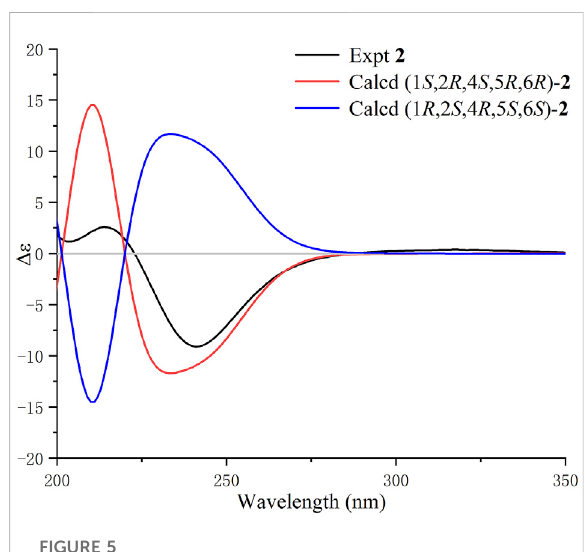
FIGURE 5 Calculated and experimental ECD spectra of 2 in